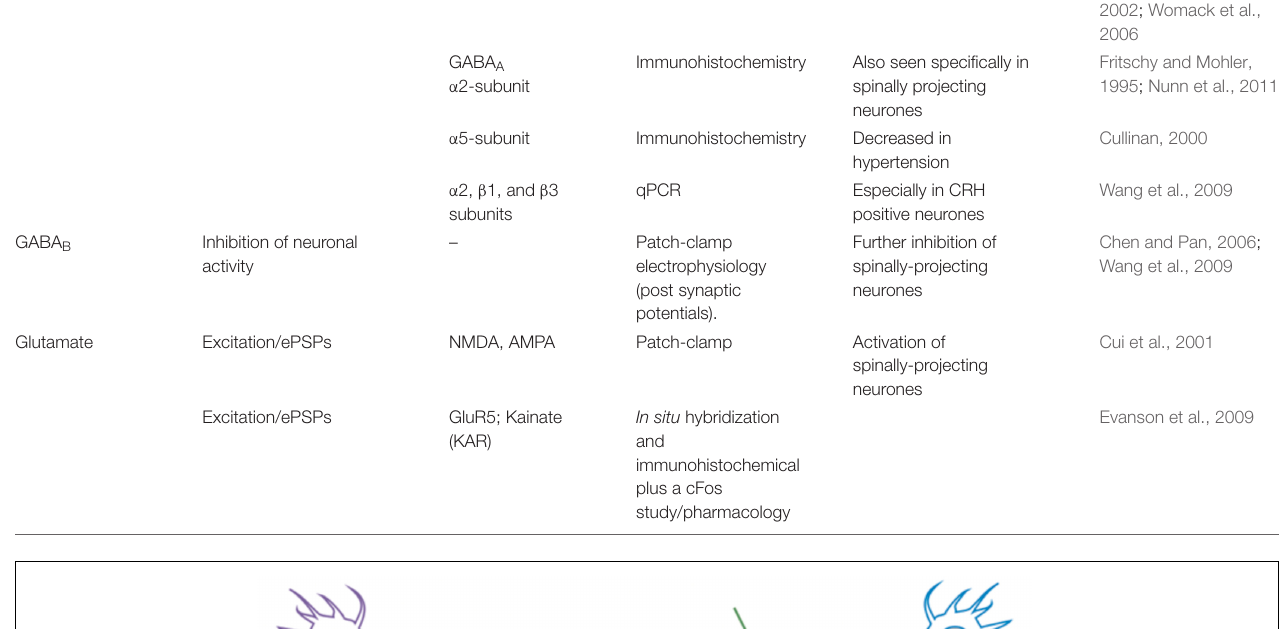
TABLE 1 | Amino acid receptor channels in the PVN.